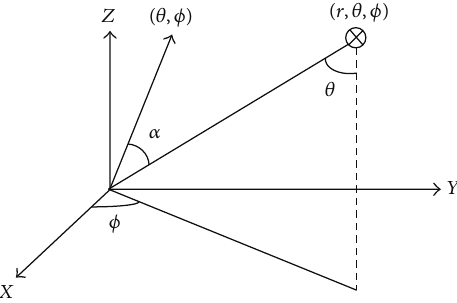
Figure 1: Reference coordinates of an arbitrary